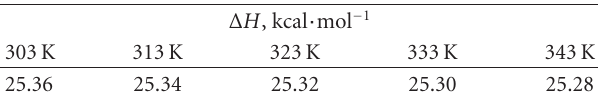
Table 8: The enthalpy of adsorption ( Δ H ) for carbon steel in 1.0 M HCl in the presence of the aqueous extract of (2.0g/L) Neem leaves at various temperatures (303K − 343K).